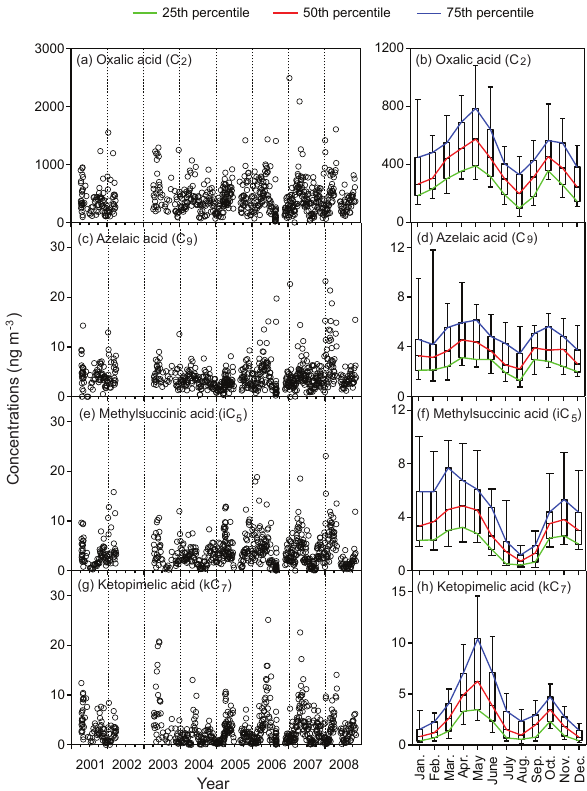
Figure 2. Seasonal variations in selected saturated and multifunc- tional diacids, including oxalic (a, b) , azelaic (c, d) , methylsuc- cinic (e, f) and ketopimelic (g, h) acids, in ambient aerosol samples. The right panels are drawn based on the monthly binned concentra- tions irrespective of the years. The lower and upper whiskers rep- resent the 10th and 90th percentiles, respectively. The outliers are excluded in the right panels to avoid any distortion in the seasonal- ity.